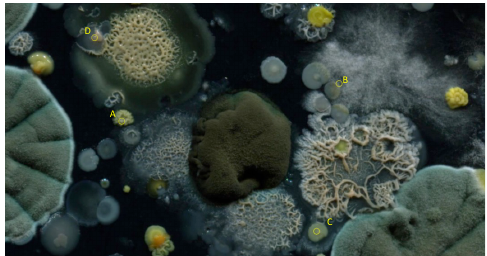
Figure 18. The final frame of petri dish 3, with four locations marked on different colonies.